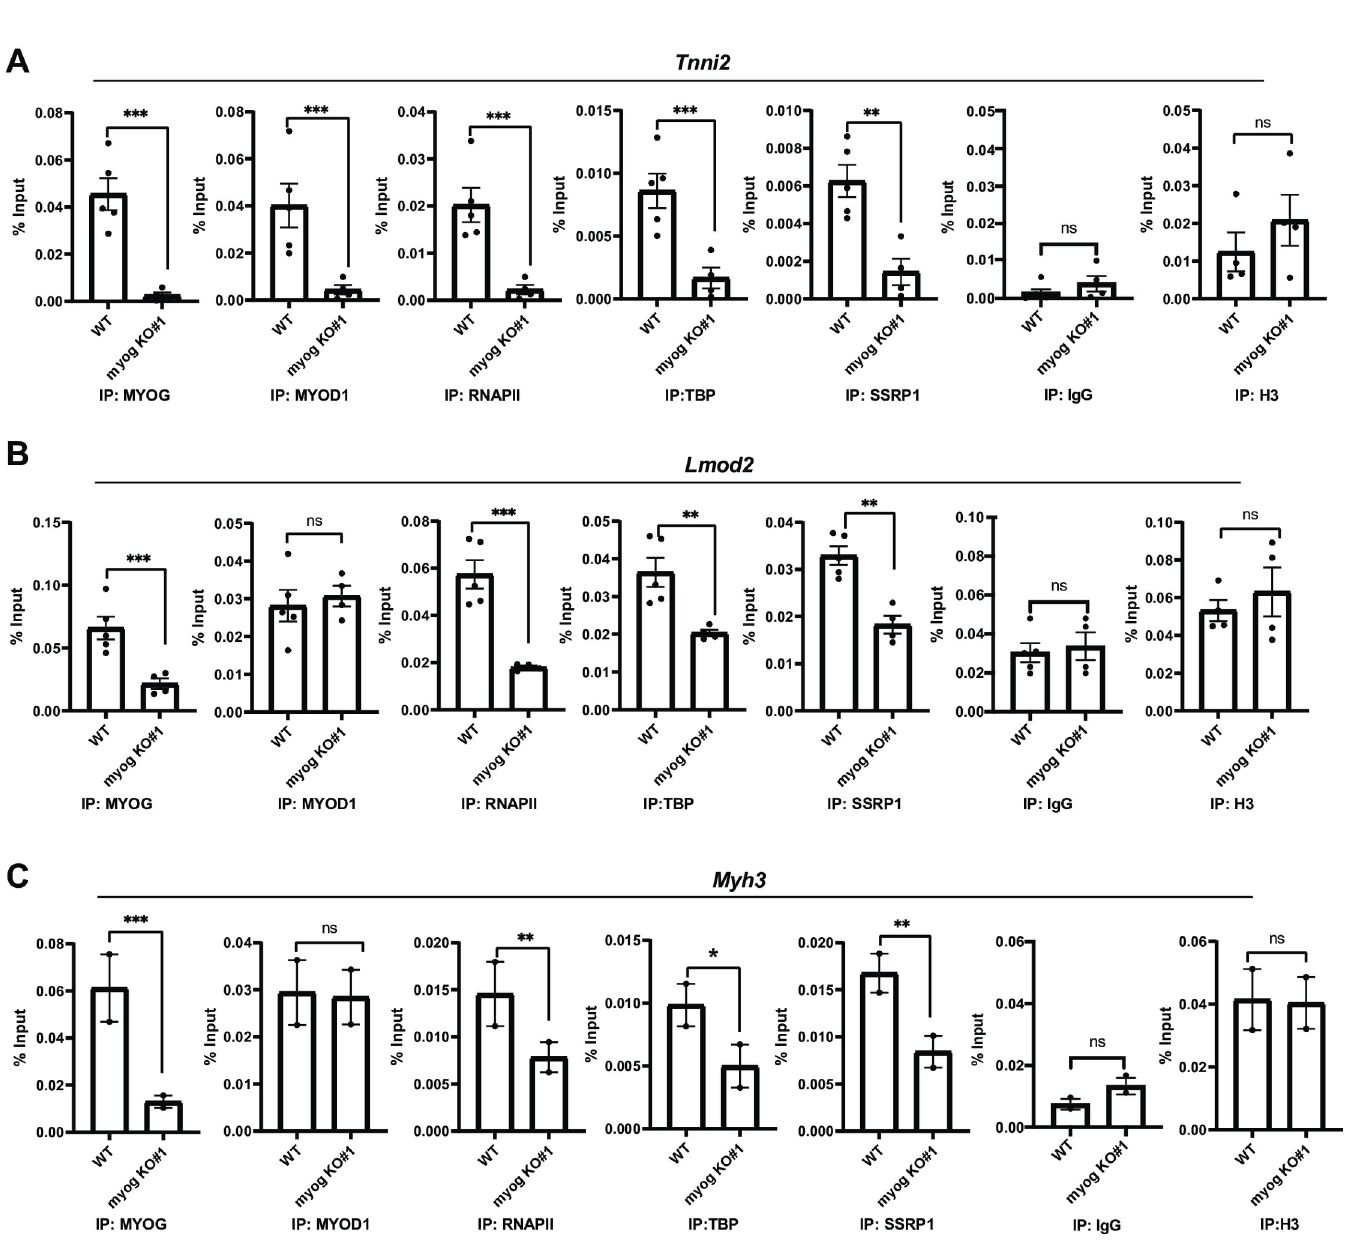
Fig 5. Deletion of Myog impairs transcription assembly at muscle gene promoters. A-C. ChIP assays were performed on stable C2C12 cells with Myog deletion using antibodies against MYOD1, MYOG, SSRP1, TBP, RNAPII and histone 3(H3), and primers spanning Tnni2 (A), Lmod2 (B), and Myh3 (C) promoters. Rabbit IgG was used as a background control. Standard errors (S.E.) from the mean (Mean ± S.E.) represents the error bars. (Student t.test; ns represents ‘not significant’, � p < 0.05, �� p < 0.01 and ��� p < 0.001, n = 3–5 biological replicates except C where n = 2 biological